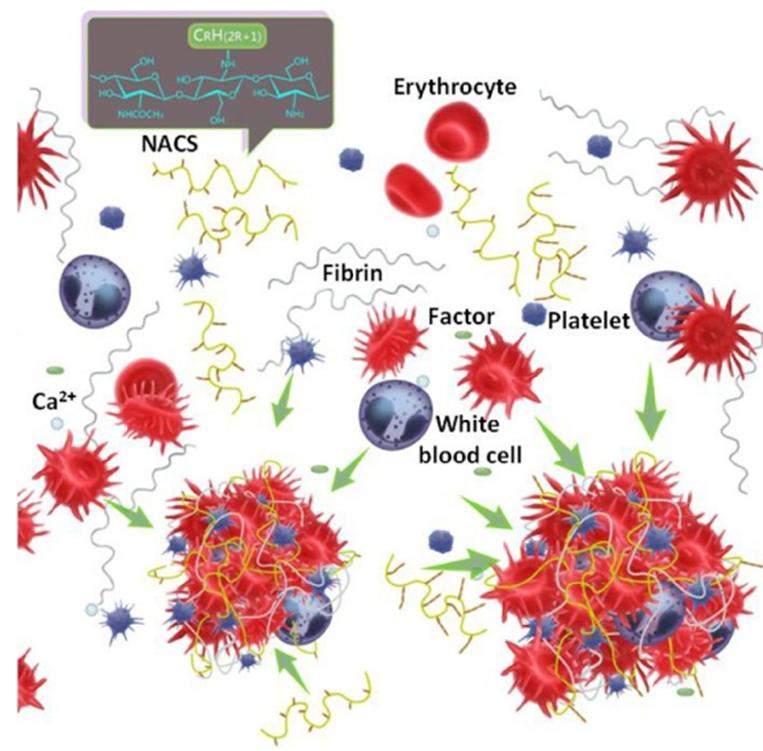
Figure 3. Coagulation process involving alkylated chitosan [30].